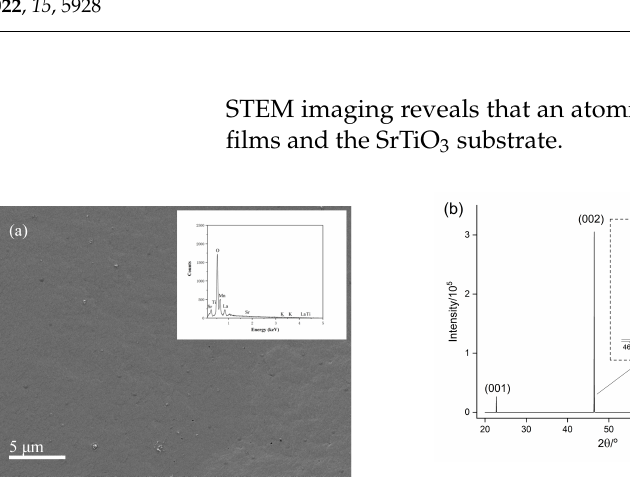
Figure 4. Characterization of the LaMnO 3 film on the SrTiO 3 substrate: ( a ) SEM image showing uniform and flat film surface. Inset: EDS spectrum; ( b ) symmetric ω /2 θ scan of the LaMnO3 film. Inset: FWHM of the LaMnO 3 film (002) peak; ( c ) symmetric ω /2 θ scan of the SrTiO 3 substrate. Inset: FWHM of the substrate (002) peak.